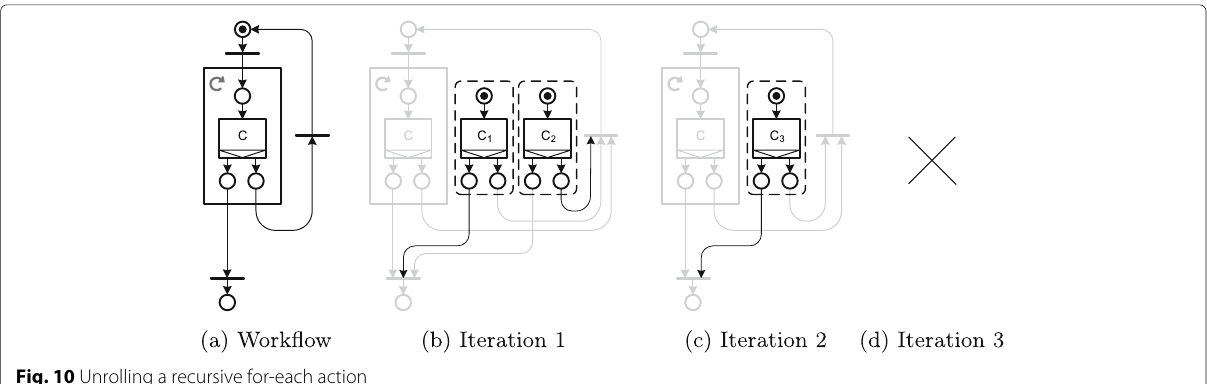
items: the output produced by C 1 after the first iteration and that of C 3 after the second